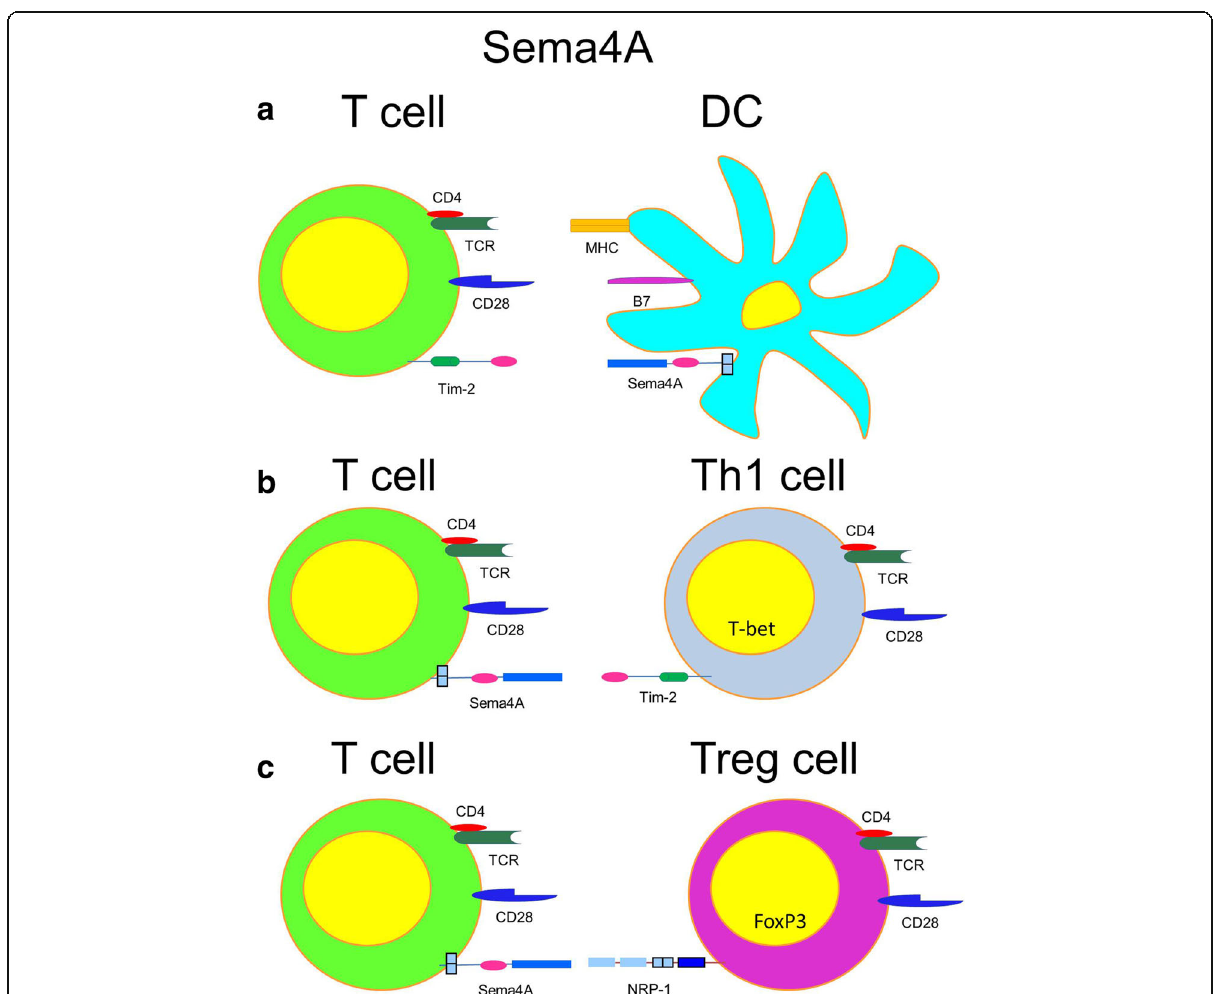
Fig. 3 Different roles of Sema4A in the immune response. a Sema4A-Tim2 pathway costimulates T cells. Sema4A on DC directly binds Tim-2 on T cells. This leads to optimal T cell activation, proliferation and cytokine production. b Sema4A in T-T cell interaction. Sema4A ligation of Tim-2 expressed on Th1 cells optimizes Th1 effector immune response. c Sema4A in T-Treg cell interaction. Expressed on conventional T cells, Sema4A ligates NRP-1 on the surface of T reg cells. This interaction induces a complex of signaling events in T reg cells directed to promote their stability and